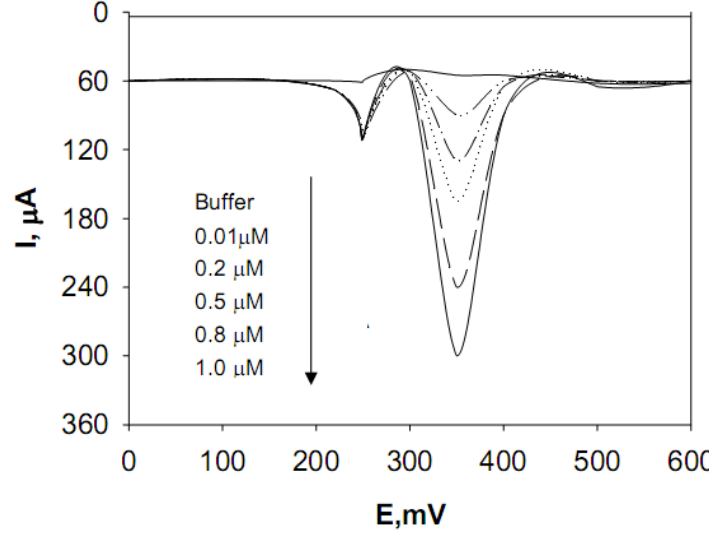
Figure 2. Differential pulse voltammograms of various concentrations of DA (ranging from 0.01  M to 1  mol/L) in 1 mM AA